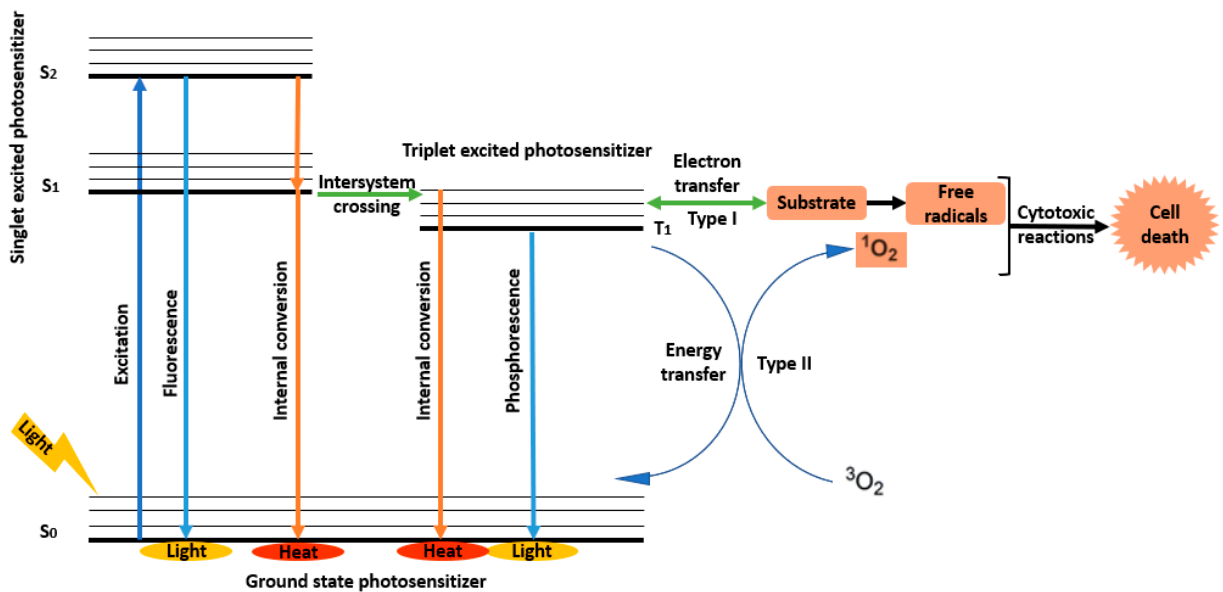
Figure 2. Schematic representation of photodynamic therapy (PDT) mechanism. Created based on literature references [2,7,8,18,26–28,32–35].